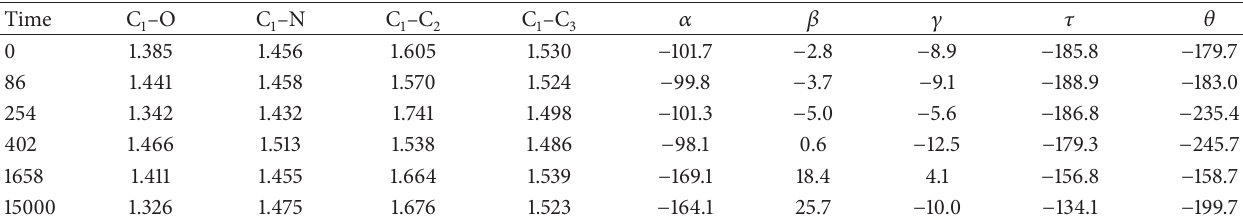
Table2:Keygeometryparametersforthedynamicsimulationofinternalconversionprocessofcis-SP(timeinfs,bonddistanceinangstroms, and dihedral angles in